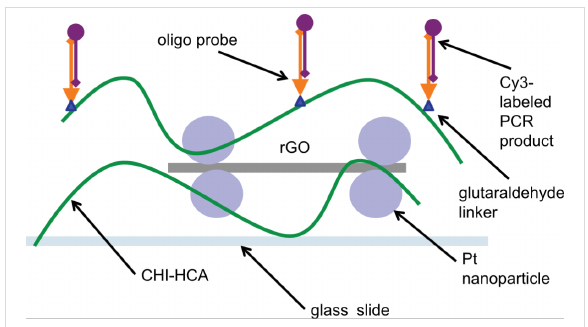
Figure 3: Schematic of printed catechol-modified chitosan/rGO–Pt nanocomposite, functionalized with DNA oligonucleotide probes and hybridized with Cy3-labeled complementary PCR